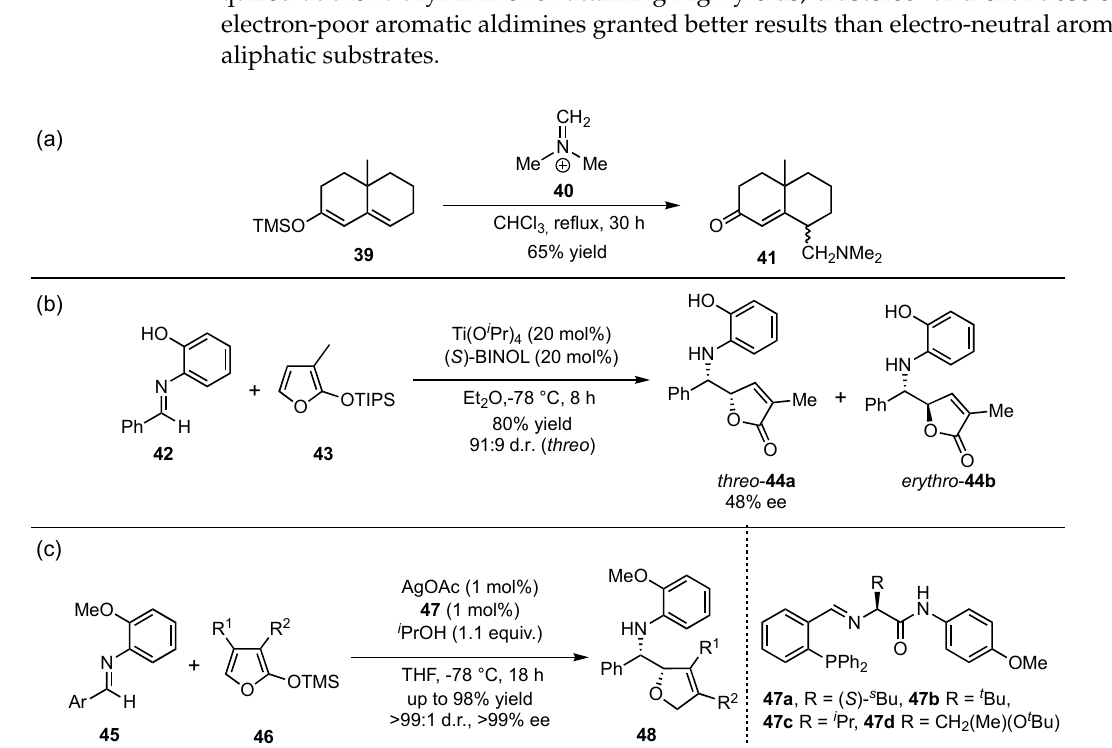
Scheme 13. First organocatalytic approach of the asymmetric VMMnR in the formation of γ -bu- tenolides by Akiyama et al. [45].